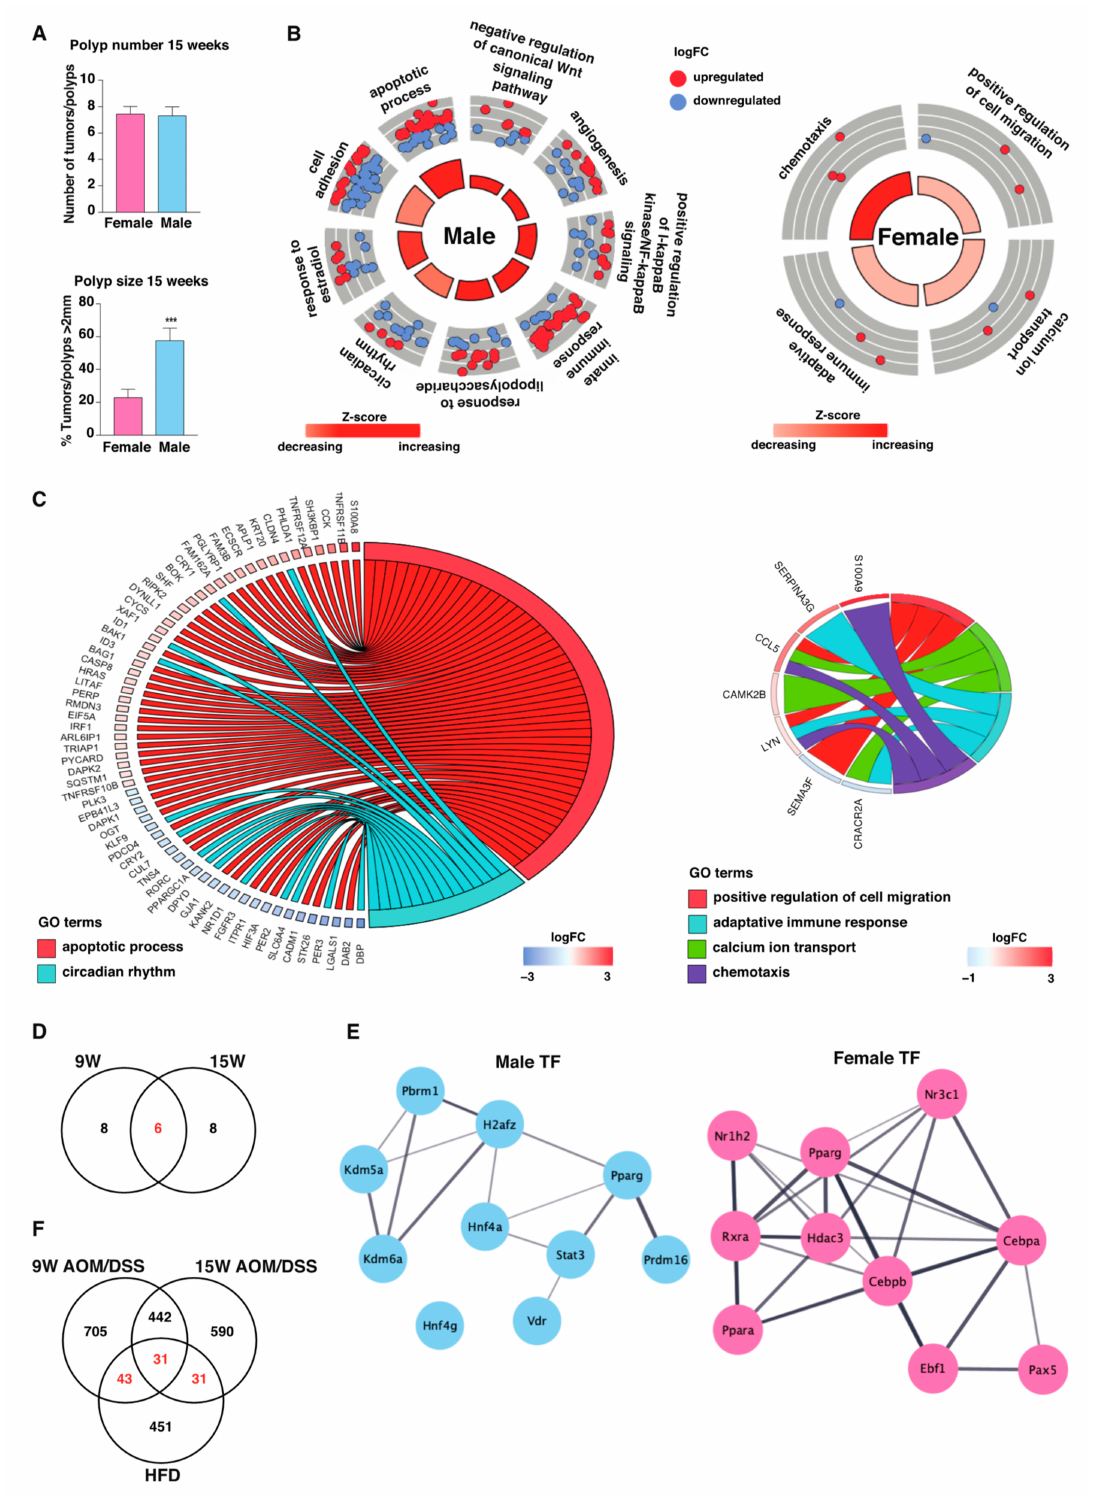
Figure 3. Males display a stronger response to 15 weeks of AOM/DSS treatment. ( A ) Comparison of number and size of polyps between males and females after 15 weeks of AOM/DSS treatment